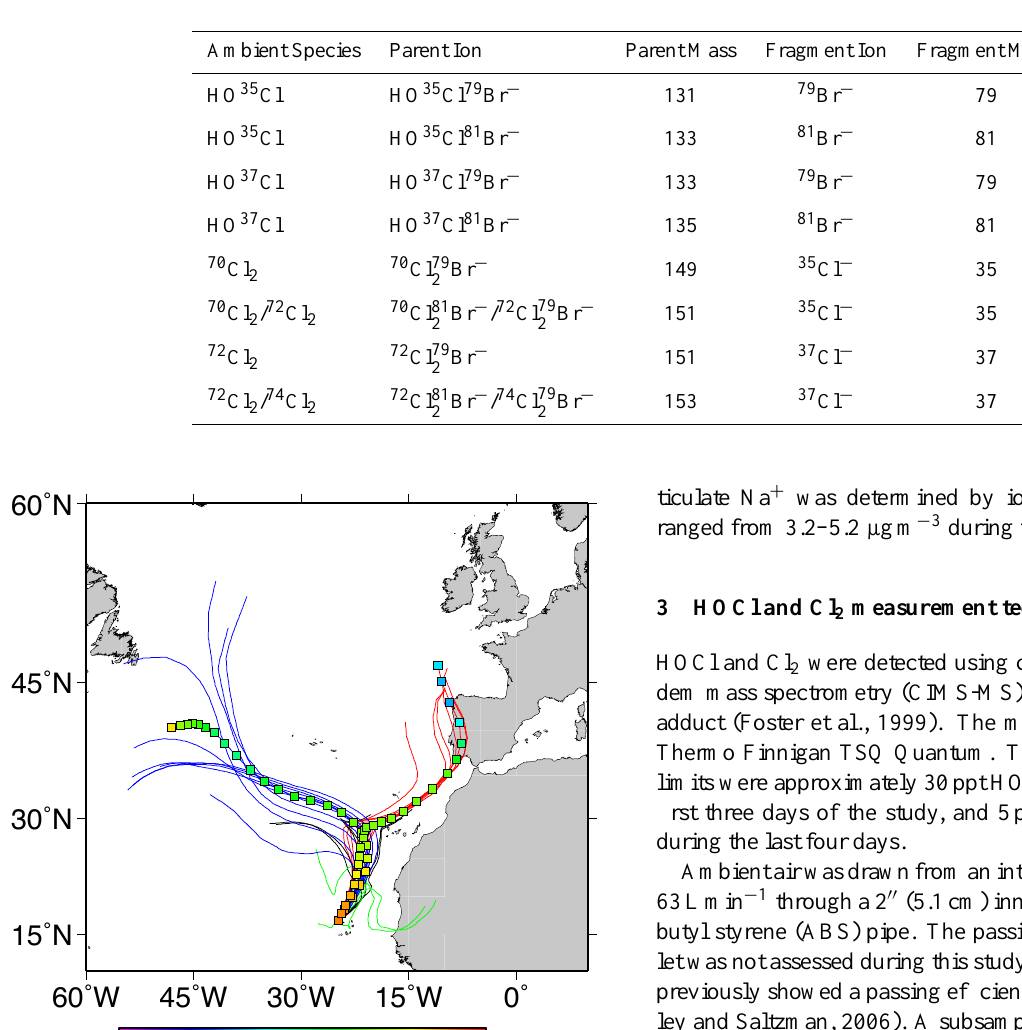
Table 1. Ambient halogen-containing isotopomers monitored by chemical ionization MS/MS during this study using Br − as the reagent ion. Parent and fragment ions used in detection are shown.